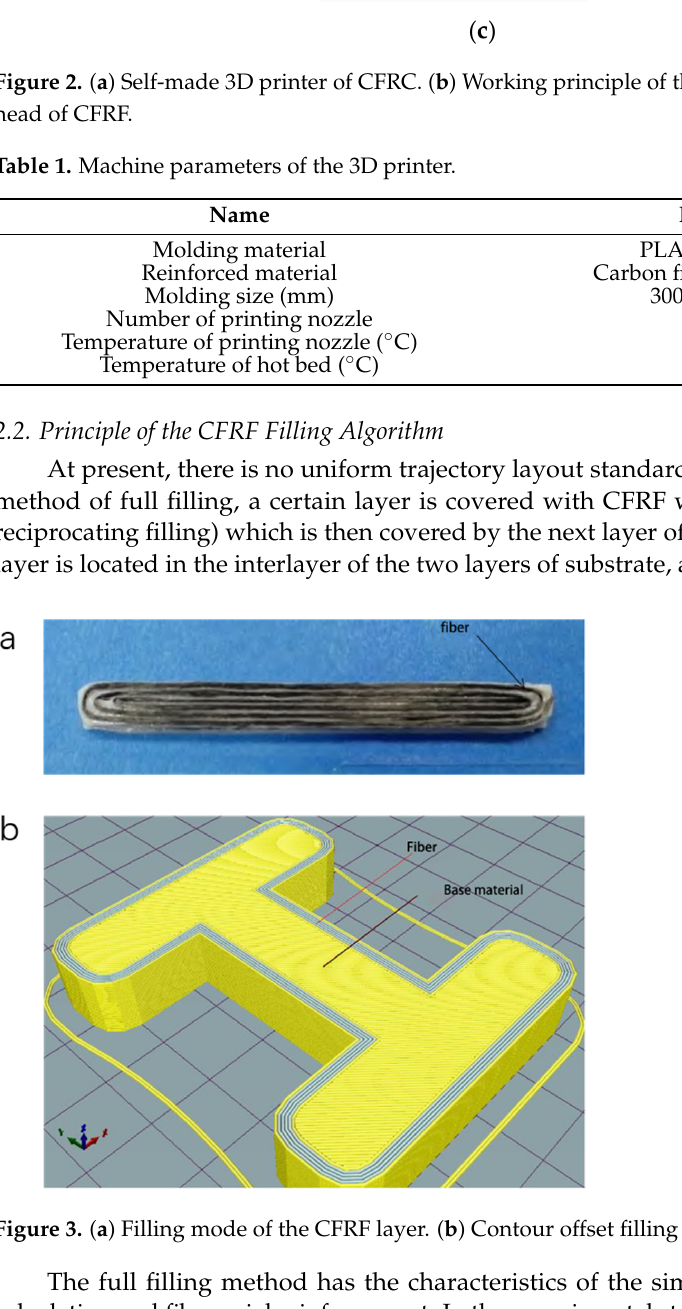
Figure 3. ( a ) Filling mode of the CFRF layer. ( b ) Contour offset filling method.